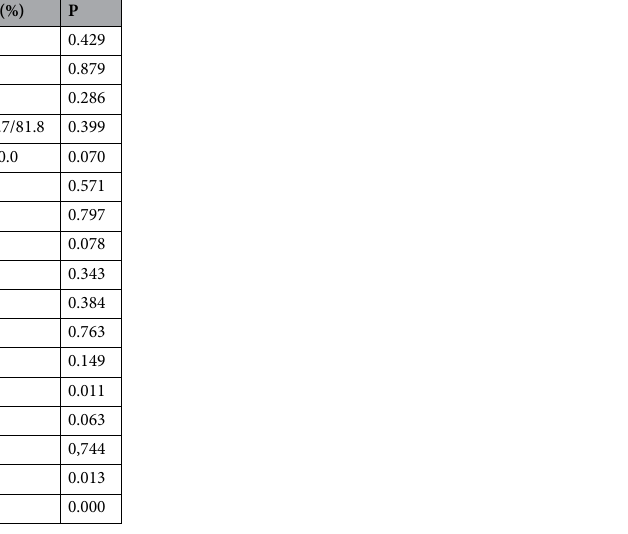
Table 3. Univariate analysis of prognostic factors of on 2-year mortality in older patients with intertrochanteric fractures (Created by SPSS 24.0 software). For example: “Complication (N/Y) 93.0/33.3”: The Survival rate in patients without complication was 93.0%, while 33.3% in patients with complication.